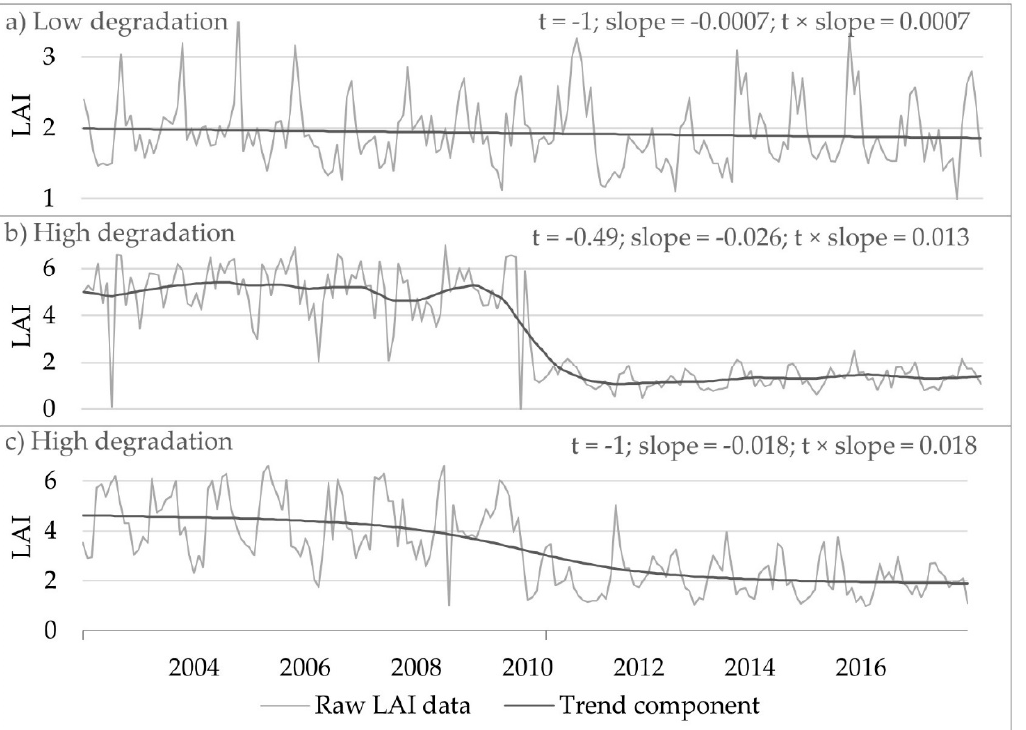
Figure 9. Examples of slightly degraded ( a ) and highly degraded ( b , c ) pixels based on the strength (t) and magnitude (slope) of the extracted trend component.